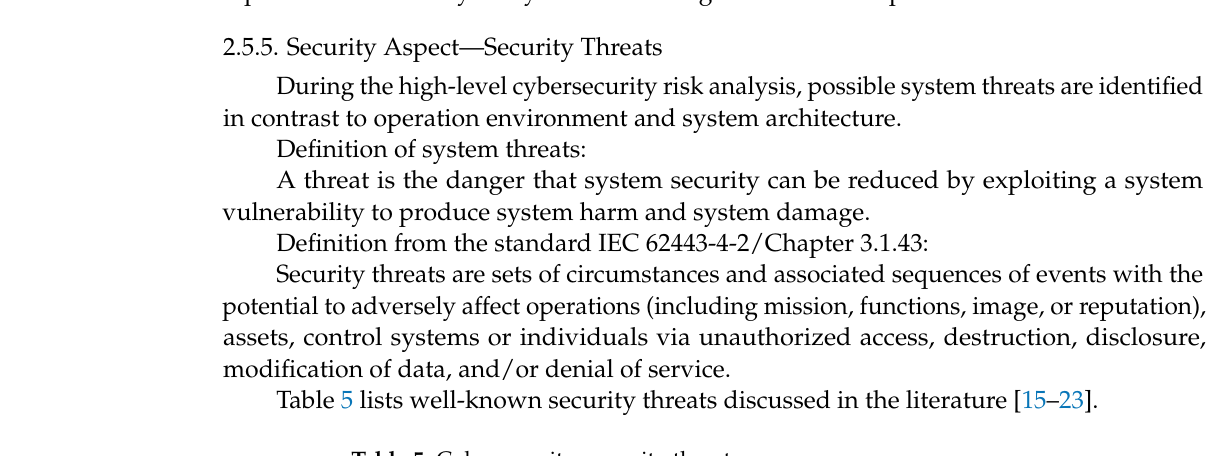
Table 5. Cybersecurity: security